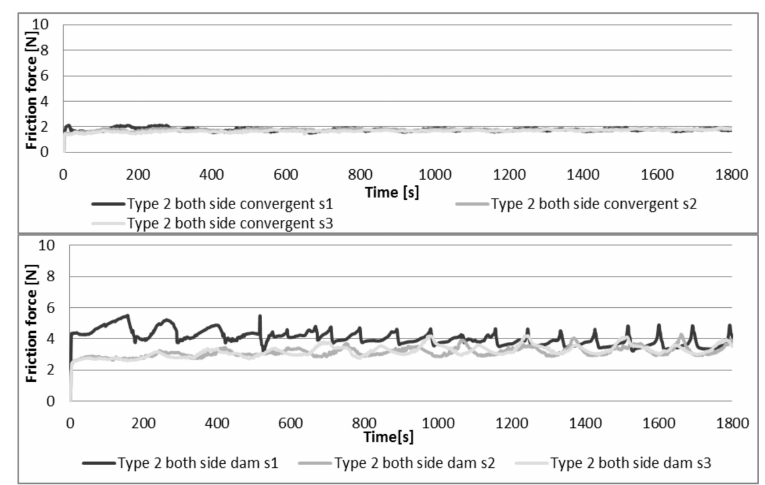
Figure 10. Friction force versus time for assemblies with a textured discs of type 2 and type 3.